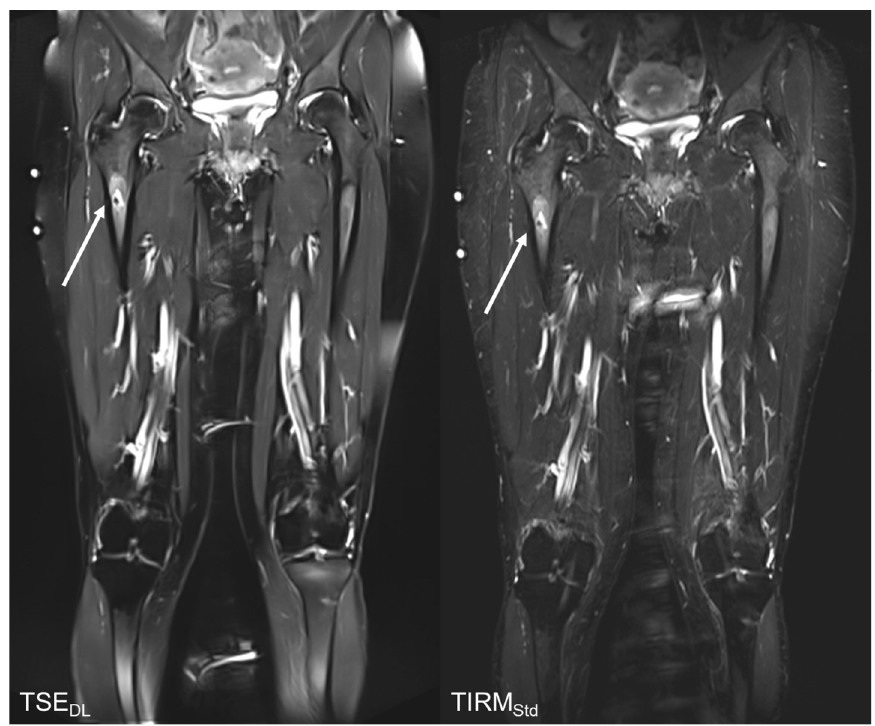
Figure 3. Follow up MRI examination of a 49-year-old with a T2w hyperintense lesion (arrows) of the right proximal femur, the finding would be compatible with enchondroma. The TSE DL shows a better image quality, contrast, sharpness, and noise and thus, allows a better diagnostic confidence.